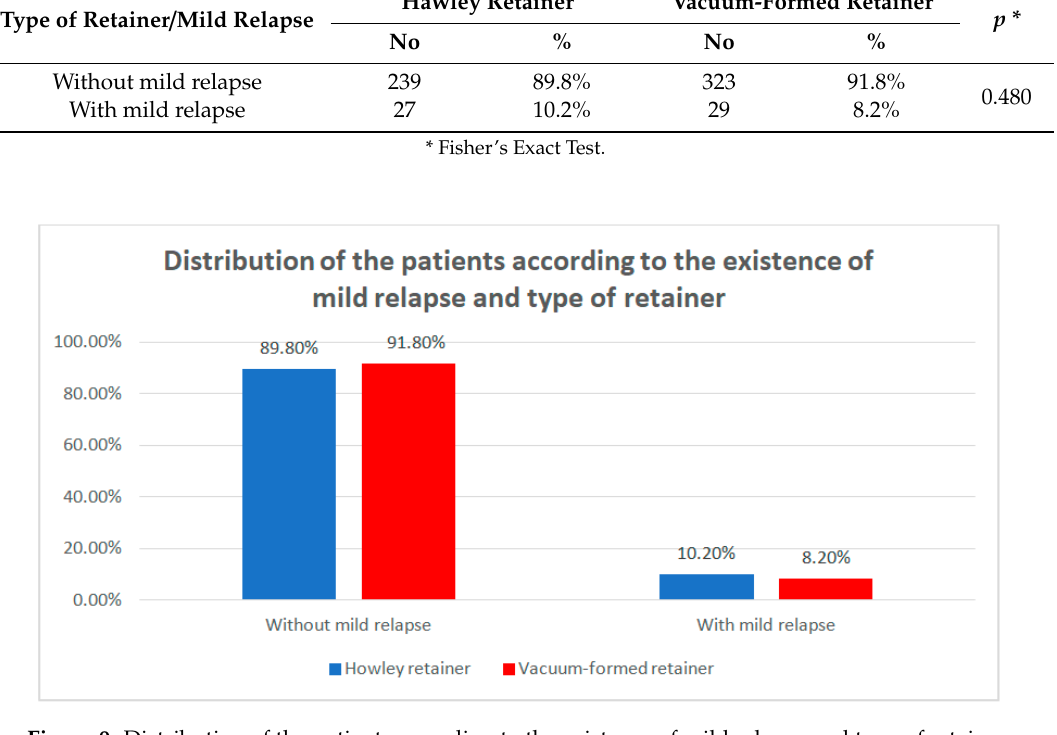
Figure 9. Distribution of the patients according to the existence of mild relapse and type of retainer.